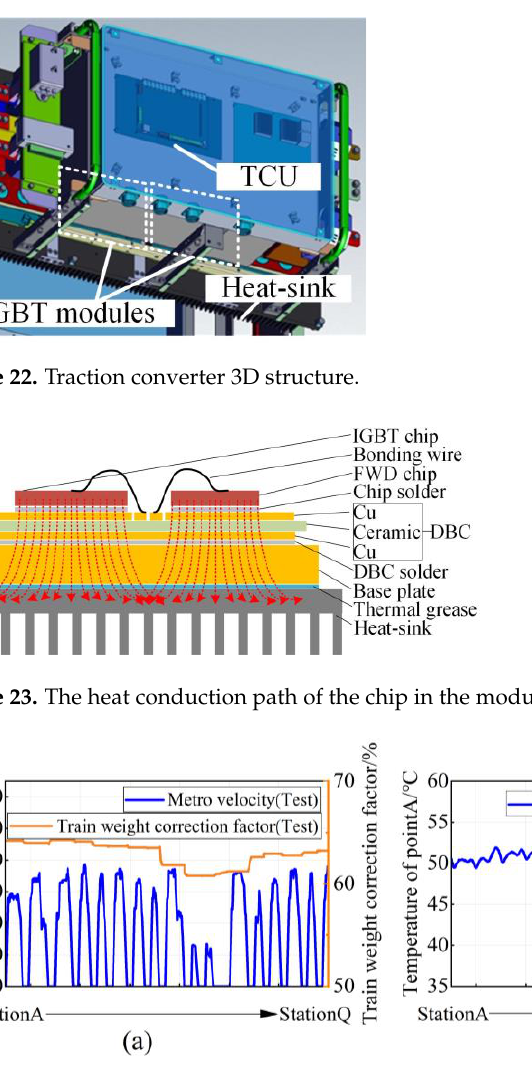
Figure 24. The results of the experiment with ( a ) the curve of the vehicle operation conditions and ( b ) the temperature of pointA in the test.